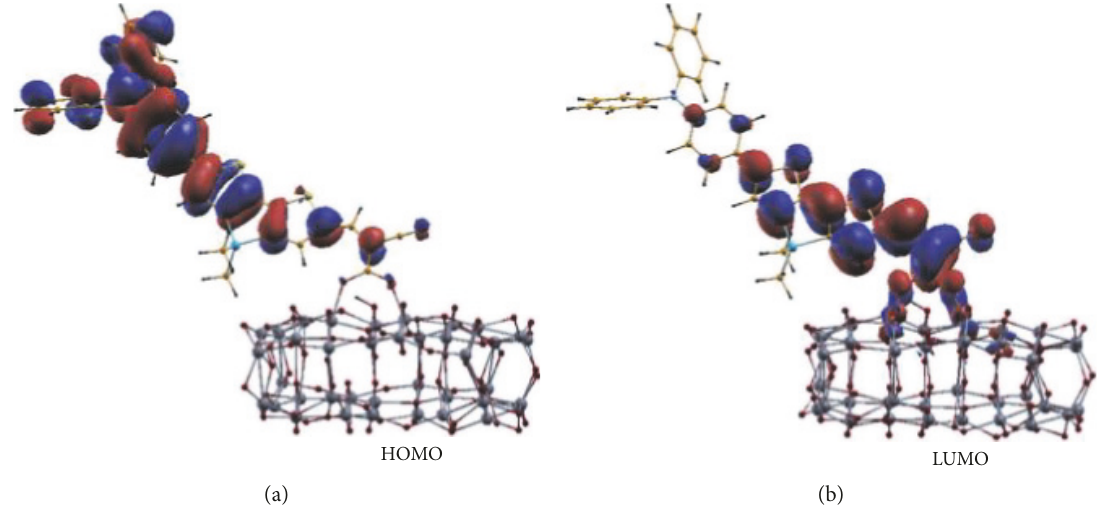
Figure 12: Molecular orbitals of CL1-TiO